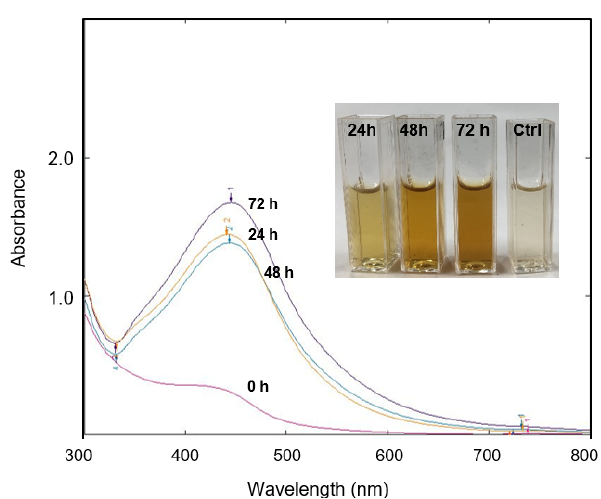
Figure 1. Observation of the LSPR band at different incubation times (0 h (nil), 24 h (441 nm), 48 h (443 nm), and 72 h (445 nm)) confirmed the formation of bioAgNPs. Inset: color changes after incubation for 24 h (light yellow), 48 h (light brown), and 72 h (brown). No color change was observed for the control solution after 72 h of